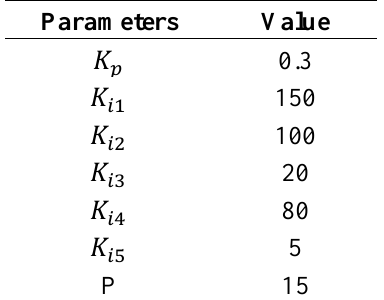
Table 1. Parameters of controller.